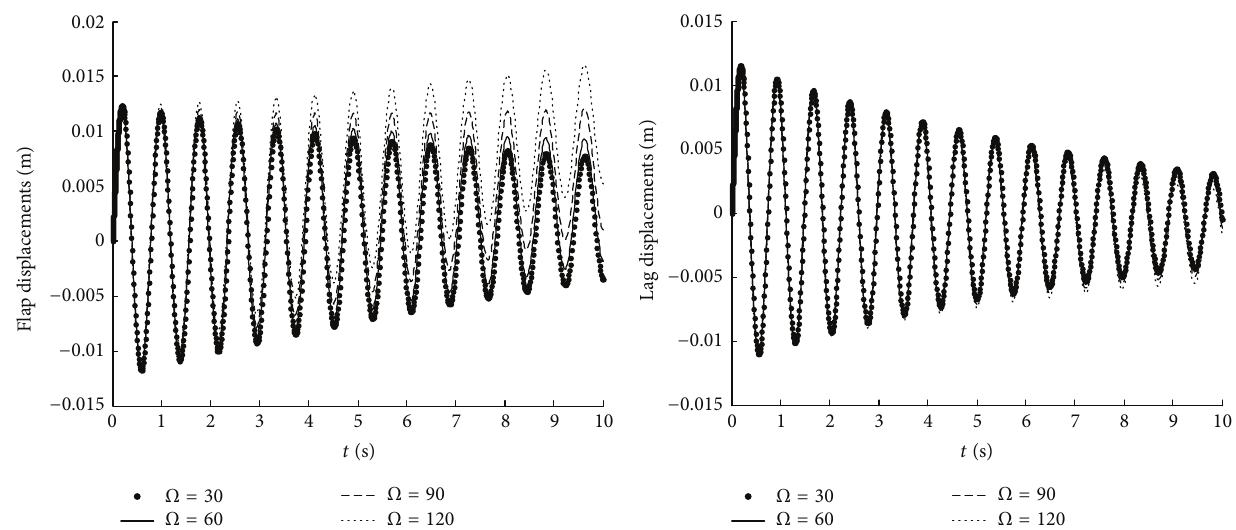
(b) Lag displacements for Ω from 30rpm to 120rpm at intervals of 30rpm Figure 2: Flap and lag displacements for Ω from 30 rpm to 120rpm at intervals of 30